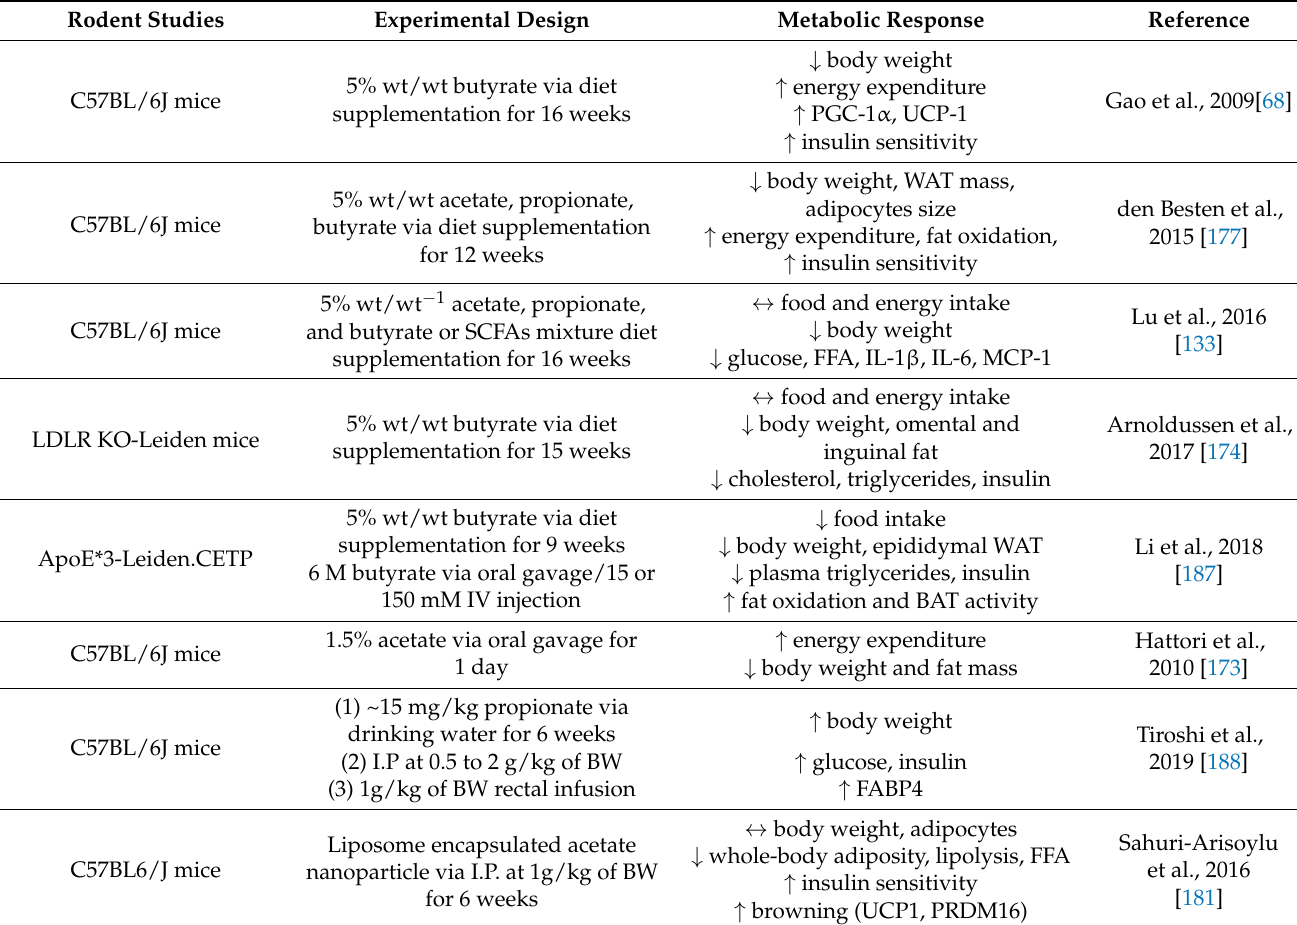
Table 4. Exogenous administration of SCFAs to impact adipose tissue metabolism in